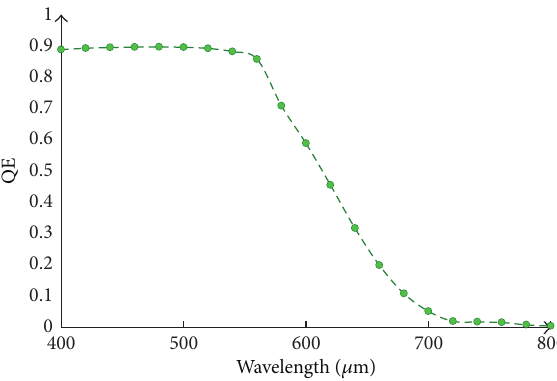
Figure 7: Quantum efficiency under one sun standard